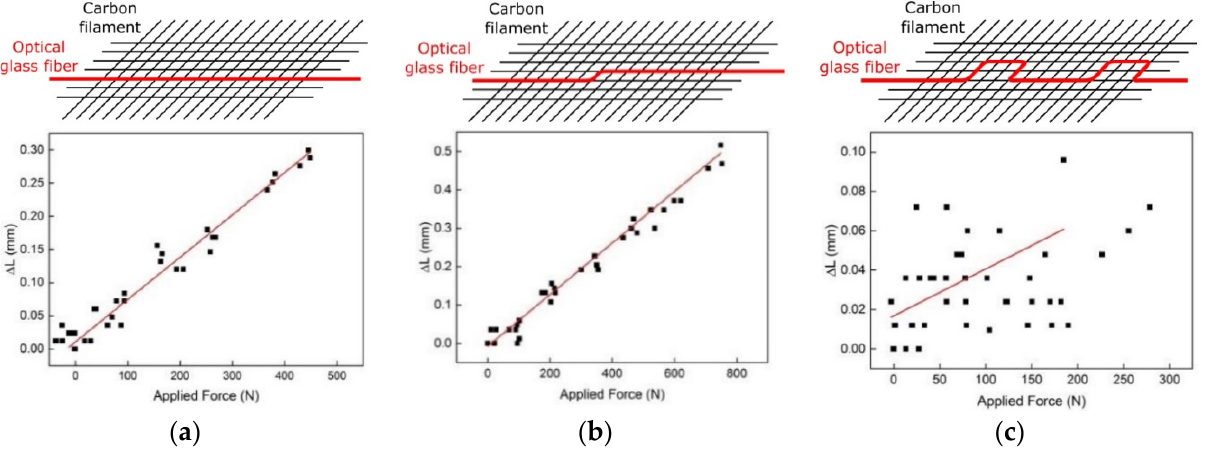
Figure 16. Responses of the functionalized textile-based reinforcement structure to applied force by different fiber optic sensor configurations: straight ( a ), offset ( b ) and meander ( c ) [96].